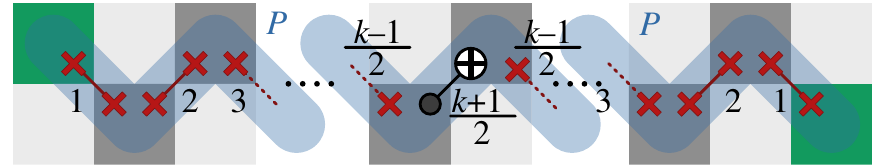
FIG. 4. A nonlocal CNOT can be implemented using SWAP gates that take depth 2 (cid:5) ( k − 1 )/ 2 (cid:6) using a zigzag of ancilla patches along the path P of length k . The figure shows the case when k is odd and the depth of the SWAP circuit is 2 ( k − 1 ) . The patches on the path can store other logical information, which will simply be moved during the SWAP gates. The patches adjacent to the path are ancillae that are used to implement the SWAP